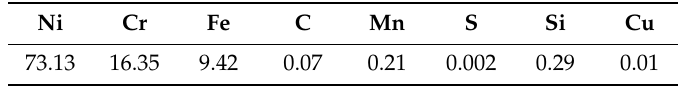
Table 1. Chemical composition of Alloy 600 used in the experiments (wt. %). (This chemical composition is provided by the